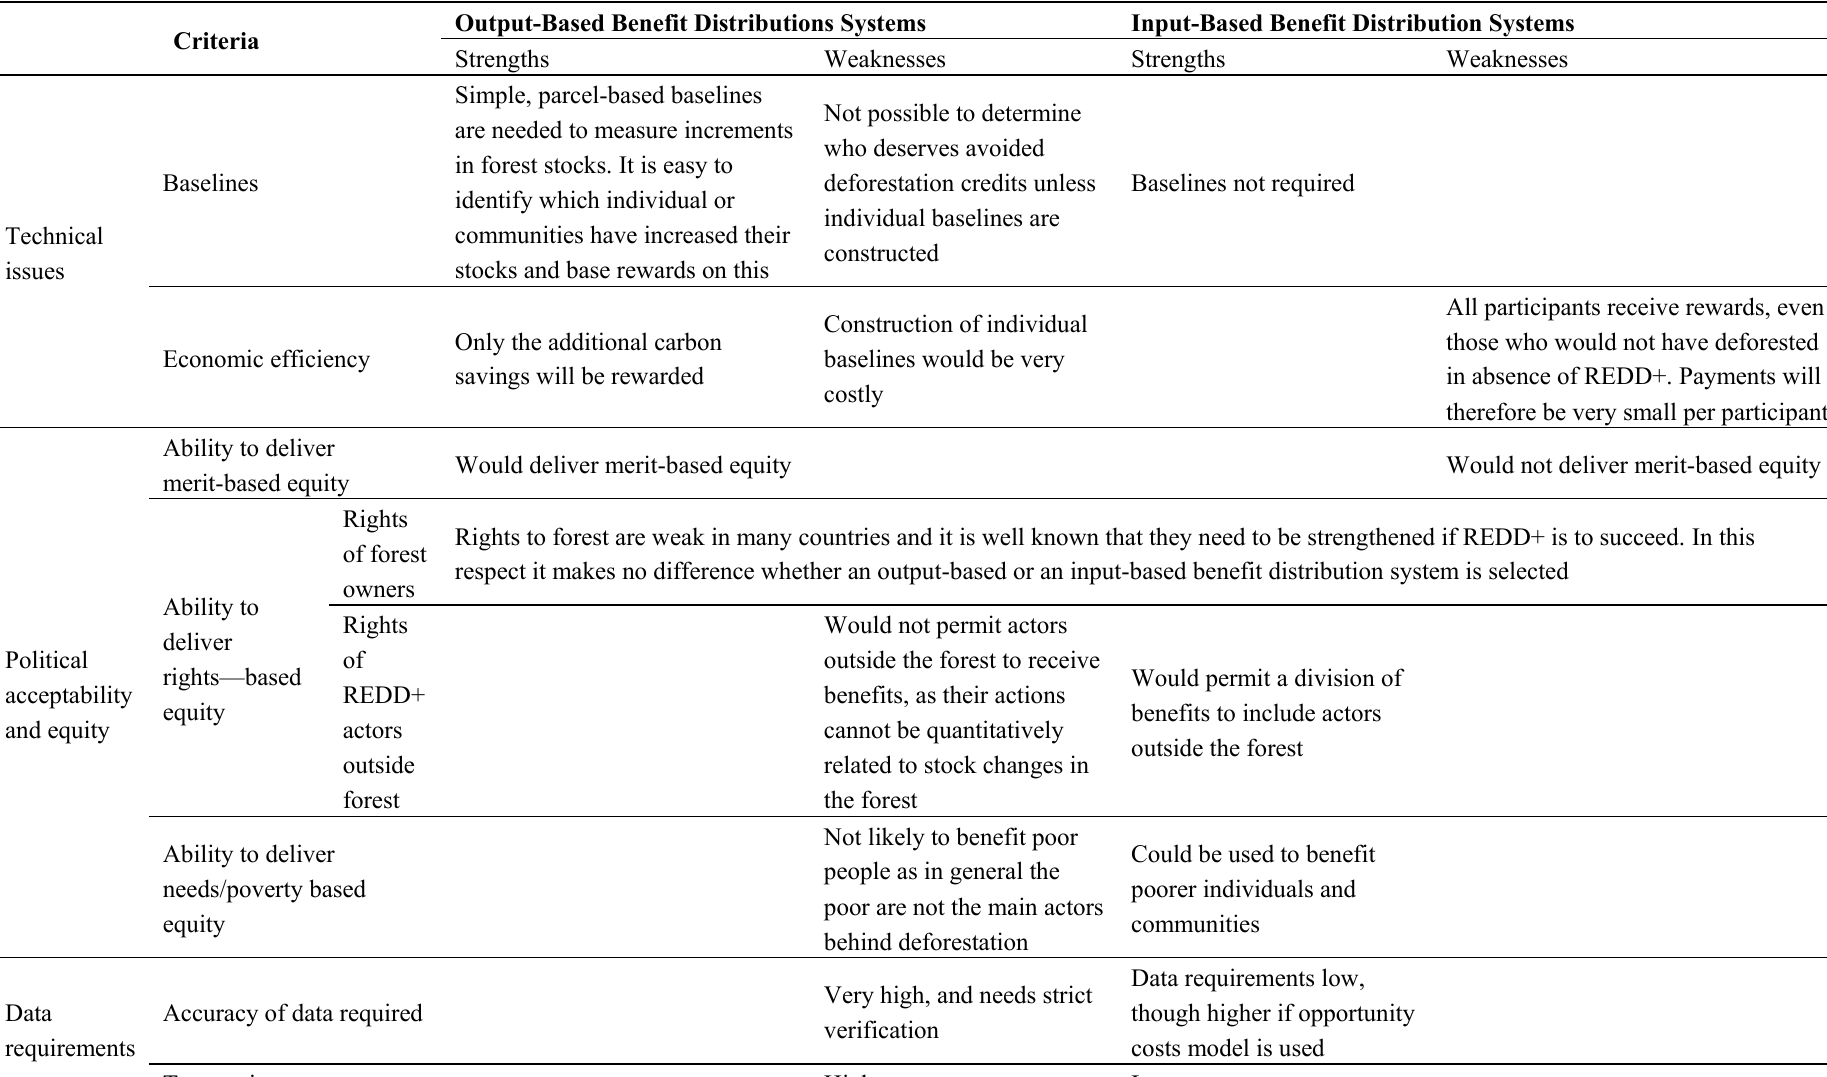
Table 1. Strengths and weaknesses on output- and input-based benefit distribution systems under national